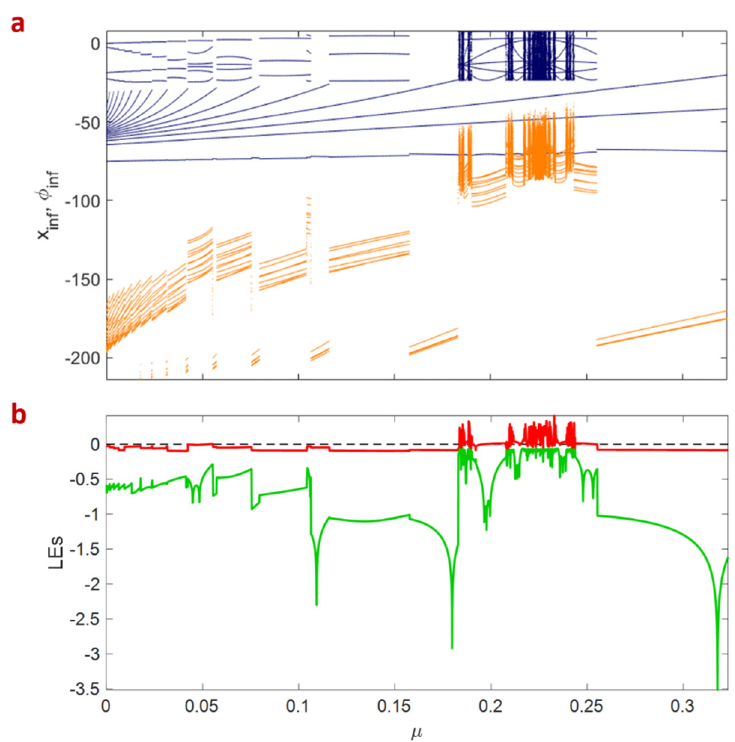
Figure 2. ( a ) The bifurcation diagram (navy blue and orange colors refer to the x and ϕ variables) and ( b ) the Lyapunov exponents’ diagram of the memristive map model by the variation of µ with considering k 1 = 0.03, k 2 = 0.15, k 3 = k 4 = 0.00001, I = 1, vr 1 = − 55, vr 2 = − 3, vc 1 = −